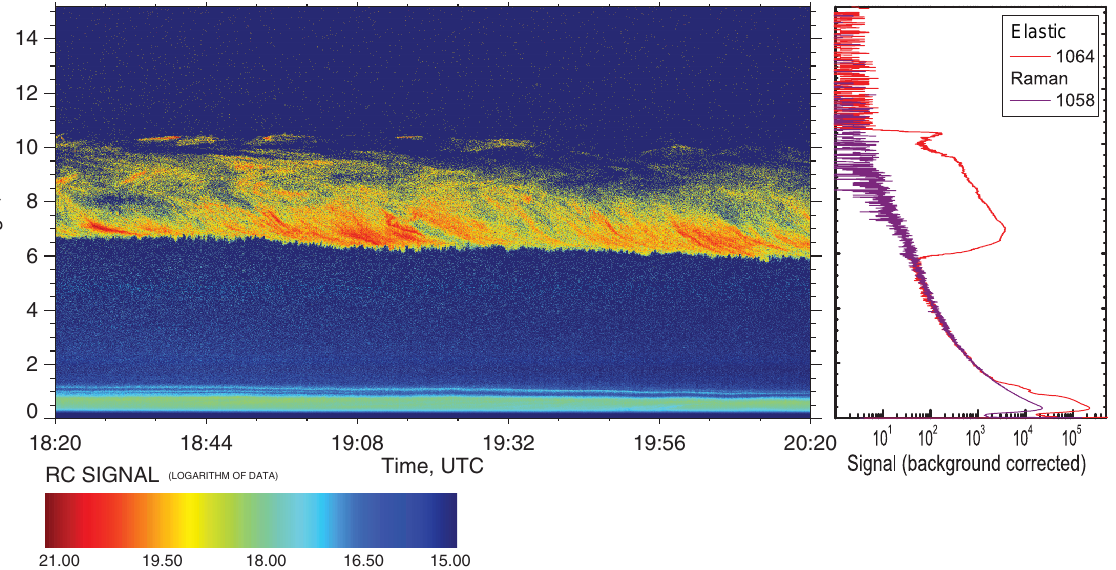
Figure 2. Cirrus observation at Leipzig, Germany, on 12 October 2015, 18:20–20:20UTC. The range-corrected 1064nm lidar return signals (7.5m resolution) indicate an ice cloud layer between 6.5 and 10.5km height with virga in the lower part. In the right panel, the signal profiles (rotational Raman channel centered at around 1058 and 1064nm elastic-backscatter channel) are averaged over the 2h period shown in the left panel.